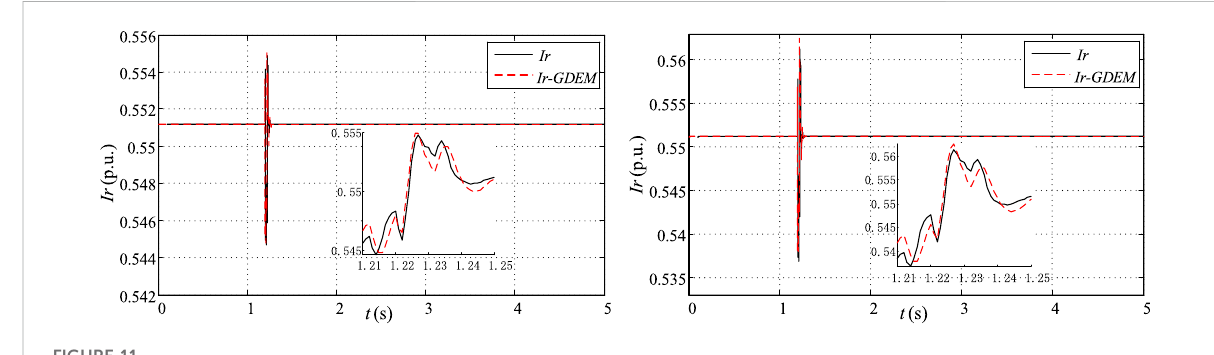
Dynamic characteristic response of the real part of the current with F13 and F14 in operating condition 4.